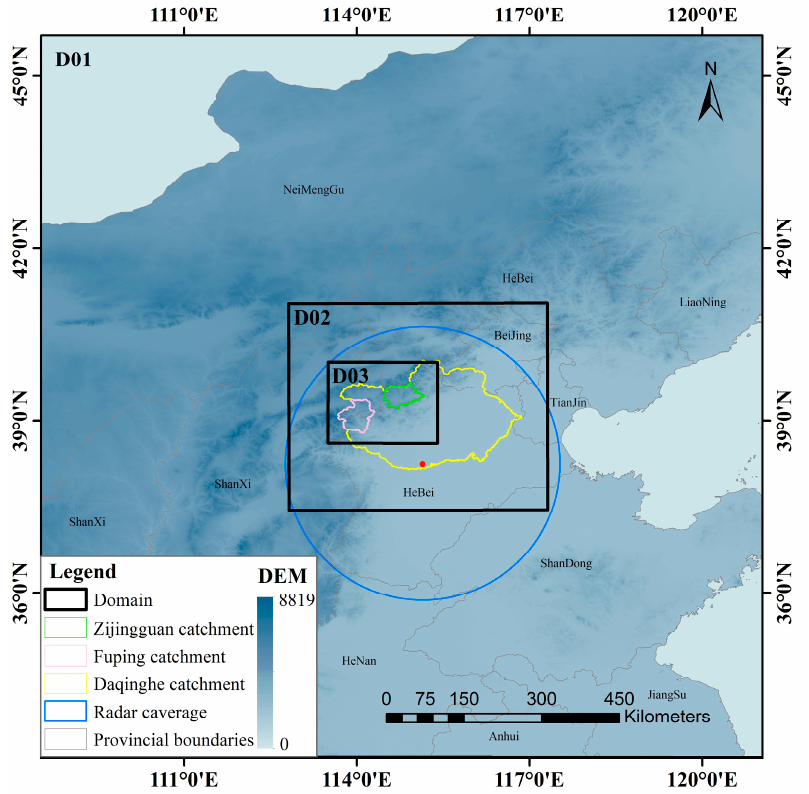
Figure 1. The study area with nested configuration of WRF domains at 9, 3, and 1 km resolution. The 1°×1° spatial resolution of Global Forecast System (GFS) forecast data provide